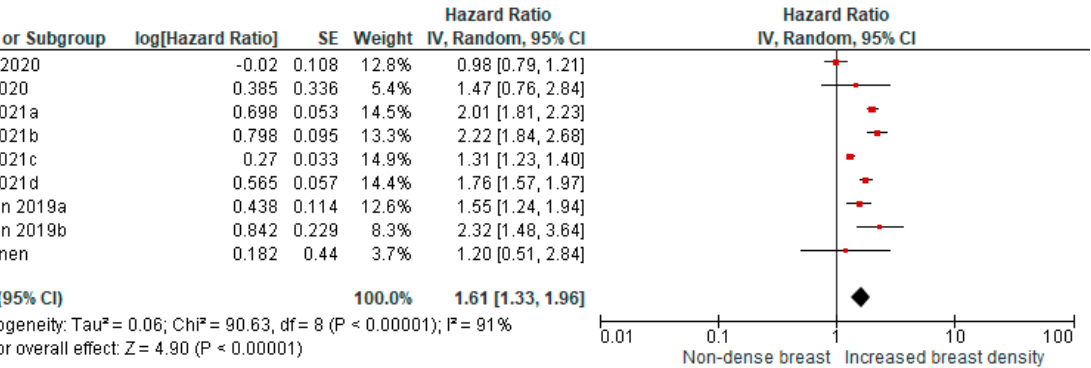
Four cohort studies with nine comparisons (using different categories of breast density changes over time) were included in the pooled meta-analysis. The studies showed a higher